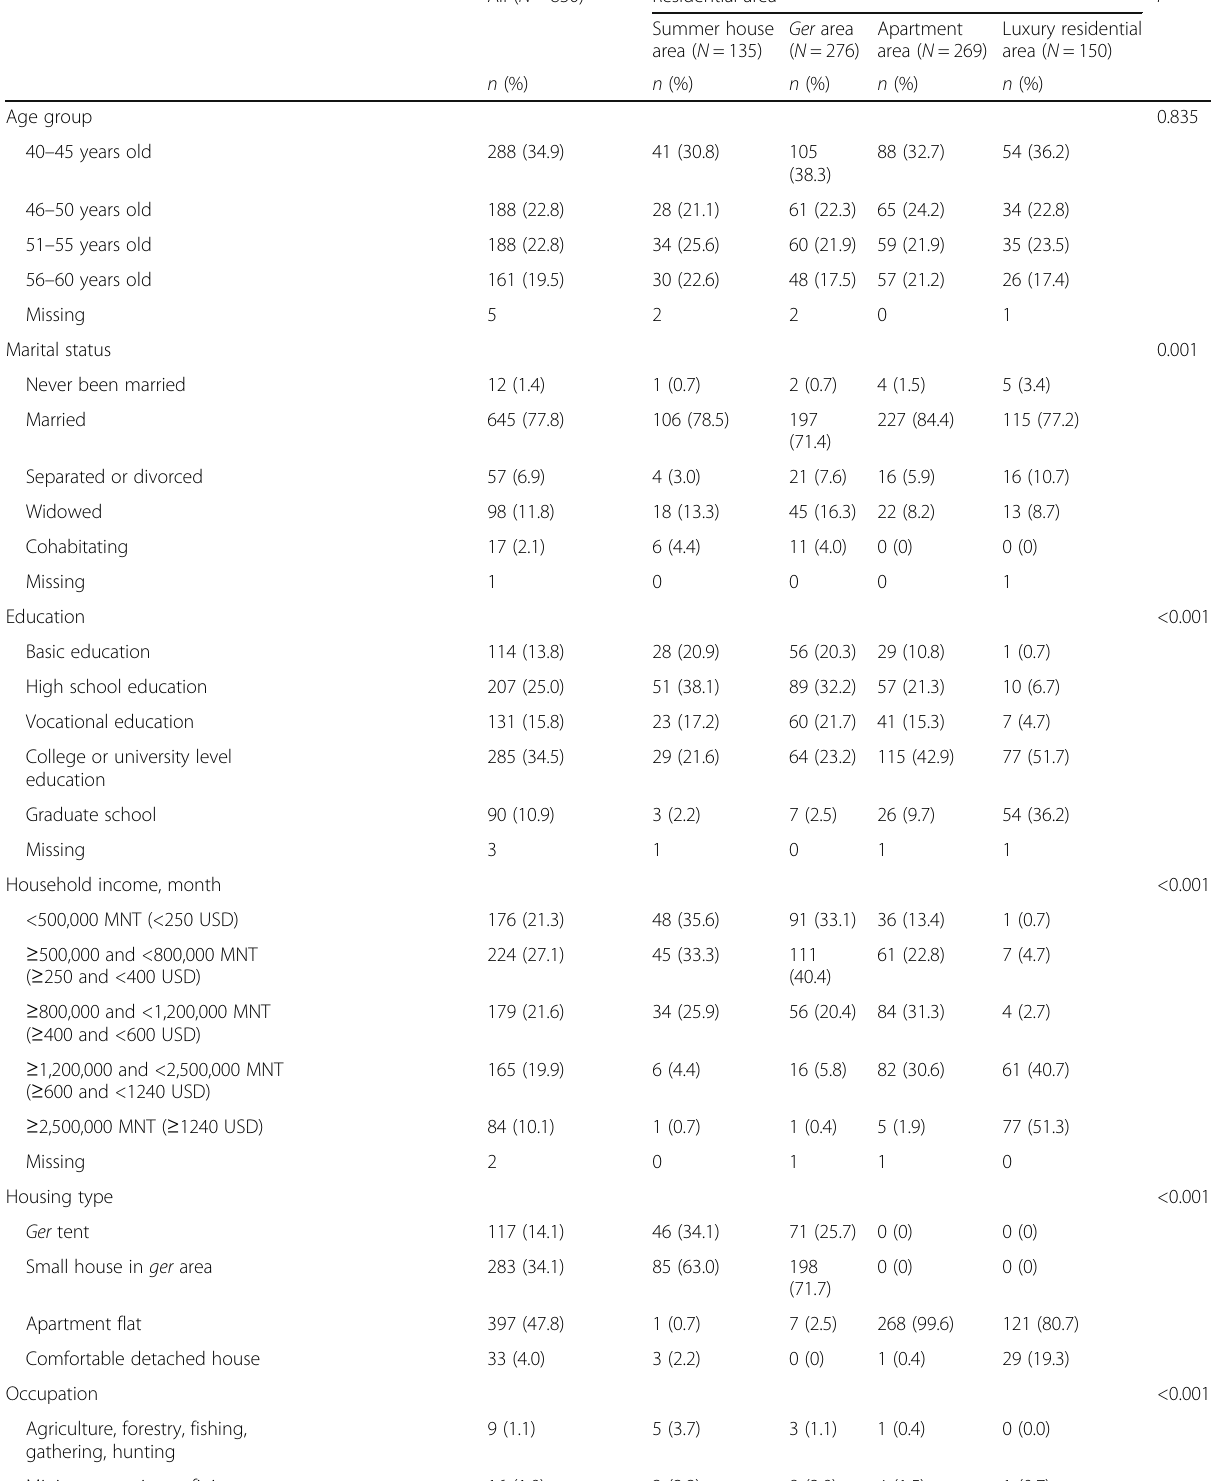
Table 1 Demographic and socio-economic characteristics and health status of the subjects according to residential area All ( N =